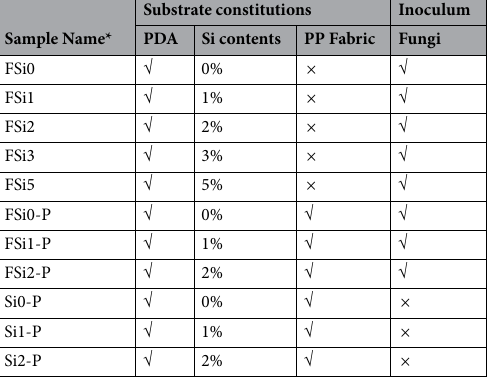
Table 1. Contrast groups of experimental samples. Annotation: × : without; √: with. *Name convention: F represents F. oxysporum , Si represents the Si source, the number represents the volume fraction percentage of Si source, P represents PP